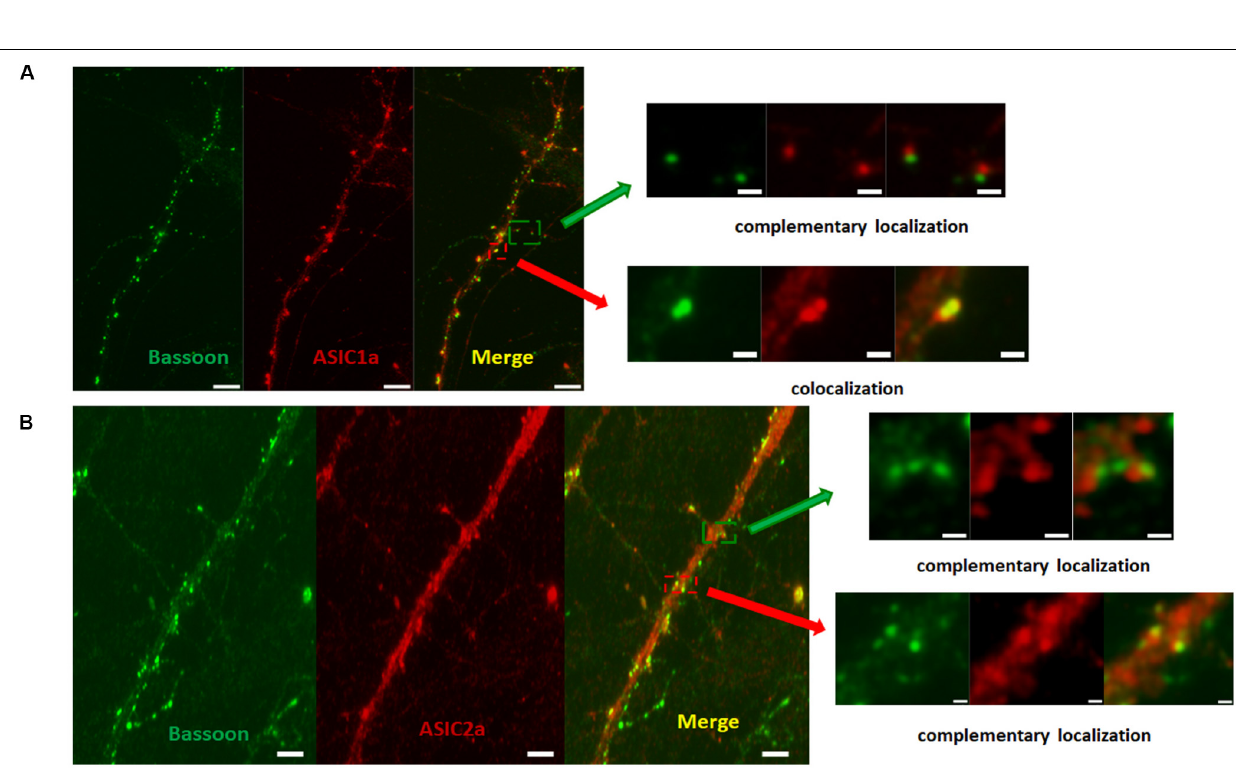
Frontiers in Cellular Neuroscience |